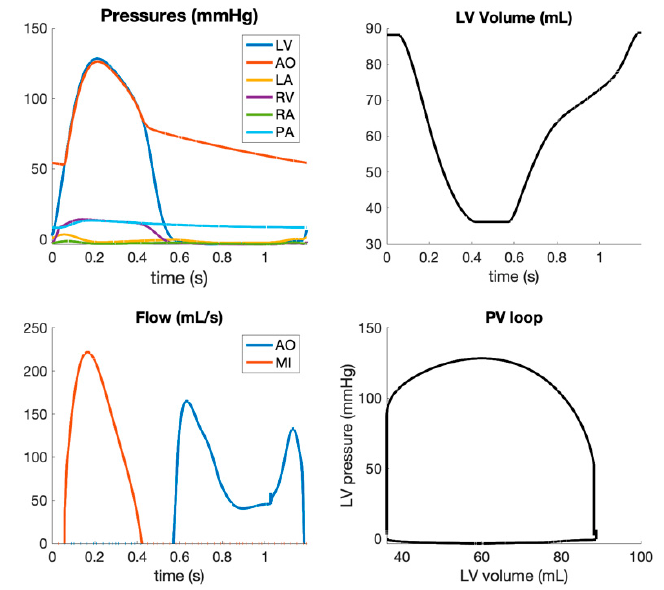
Figure 2. Hemodynamic simulations in baseline conditions.